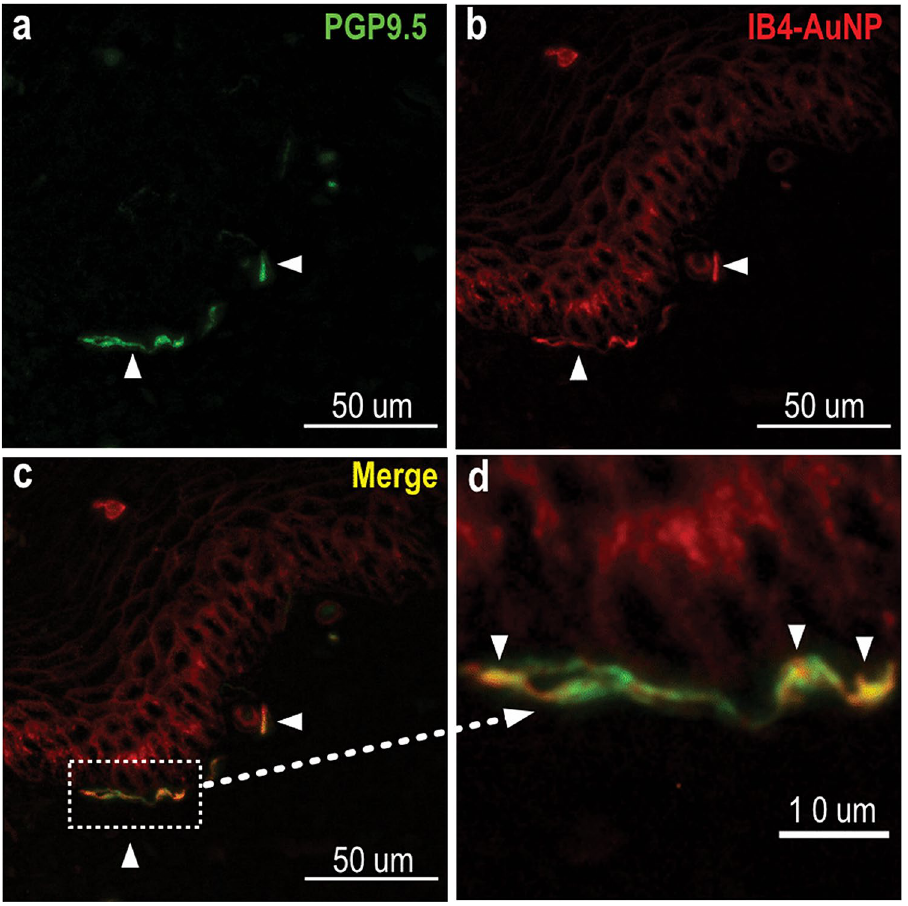
Figure 5. IB4-AuNP binding to peripheral nerve fibres in the skin. Representative fluorescent images of rat hind-paw sections treated with AuNP conjugated with DyLight 594 tagged IB4, and co-stained with